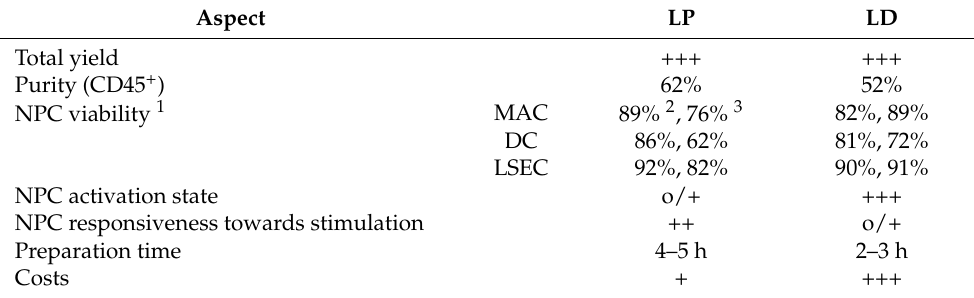
Table 2. Advantages and disadvantages of using LP or LD for NPC